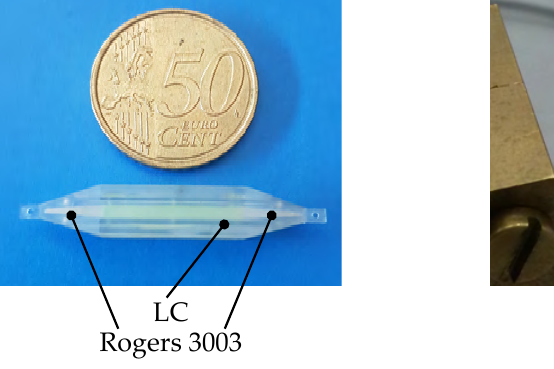
Figure 24. Fabricated phase shifter and measurement setup of the step-index phase shifter. Two of four electrodes are removed to enable a view of the LC core.